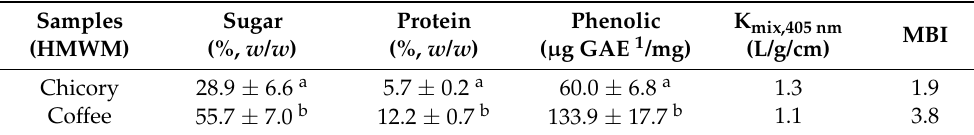
1 GAE—gallic acid equivalents. In each column, lowercase letters refer to significantly different values ( p < 0.05) among samples. The chicory HMWM presented 60.0 µ g GAE/mg sample of phenolic